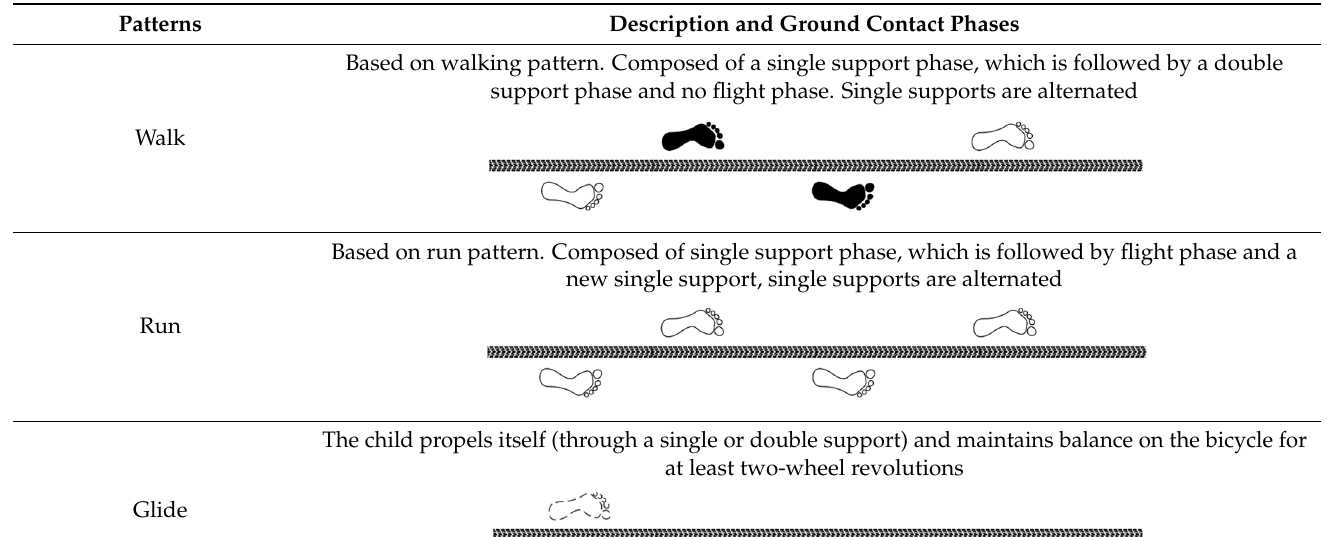
Table 1. Categorization of cycle patterns on BB based on ground contact phases description.